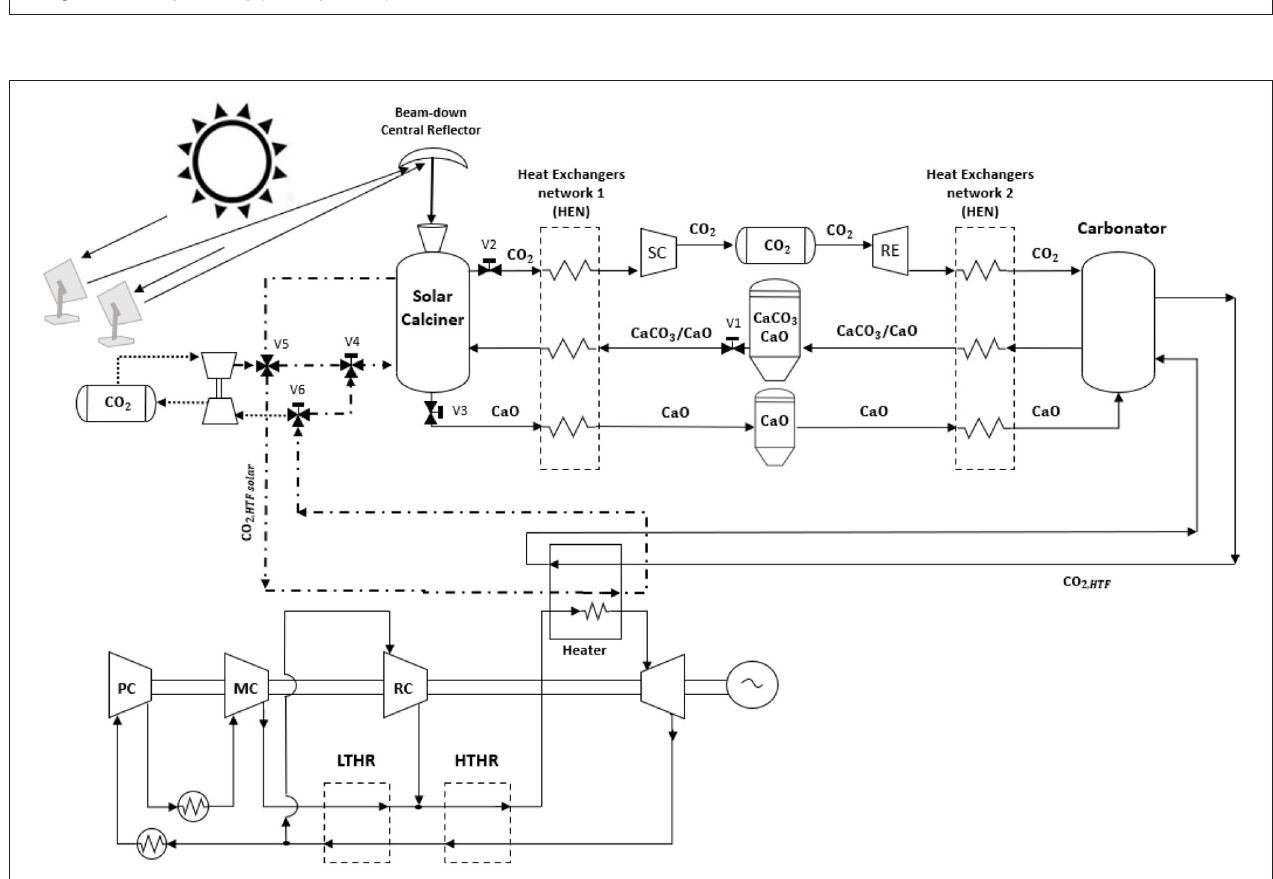
FIGURE 13 | Thermochemical/compressed gas energy storage (TC/CG-ES) coupled with an unconventional intercooling s-CO 2 Brayton cycle. During sunlight, the excess of harvested solar energy is stored in chemical compounds (i.e., carbon dioxide and calcium oxide) into the solar calciner. During the discharge process, the exothermic reaction provides heat to the s-CO 2 Brayton cycle, while the products of the reaction (i.e., calcium carbonate and unreacted calcium oxide) are stored at ambient conditions.